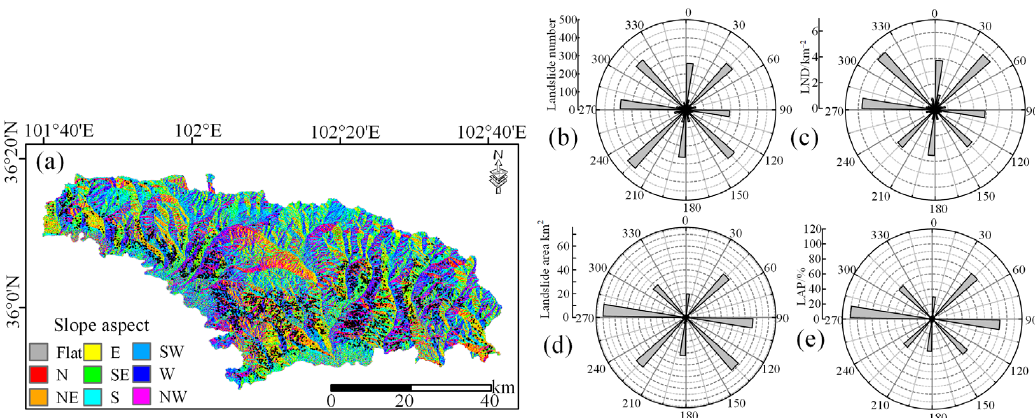
Figure 10. Relationship between aspect and landslide distribution. ( a ) Aspect distribution in the study area. ( b - e ) Statistics of landslide indicators in the aspect intervals. Table 2. Descriptions of categorized lithology in the study area.